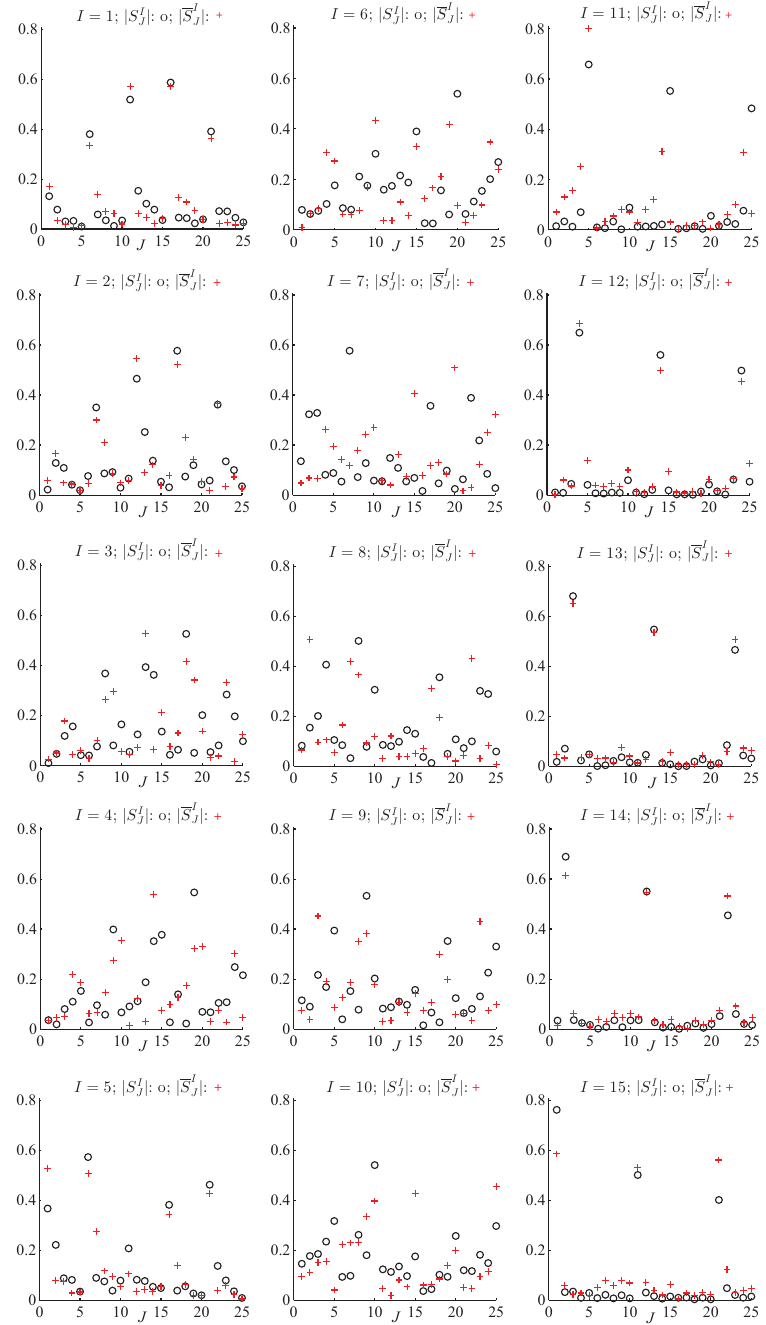
I = 1, . . . ,25, of rows S I and S I , and S J , J J ( 0 ) ( 0 ) E = 0.01 and S 55 , respectively. These are for the case 55 ( 0 ) | or | ω ( 0 ) | to their 55 55